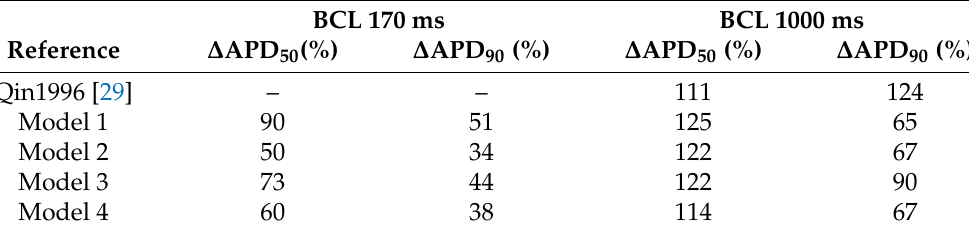
Table 3. Relative difference between APD in border zone (BZ) against normal tissue (NT) in